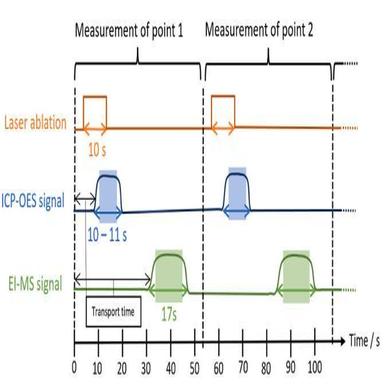
Schematic diagram of the events during a measurement showing the timing of the laser ablation relative to the ICP-OES and EI-MS signals for the same ablated sample portion as well as their individual transport times and integration windows.